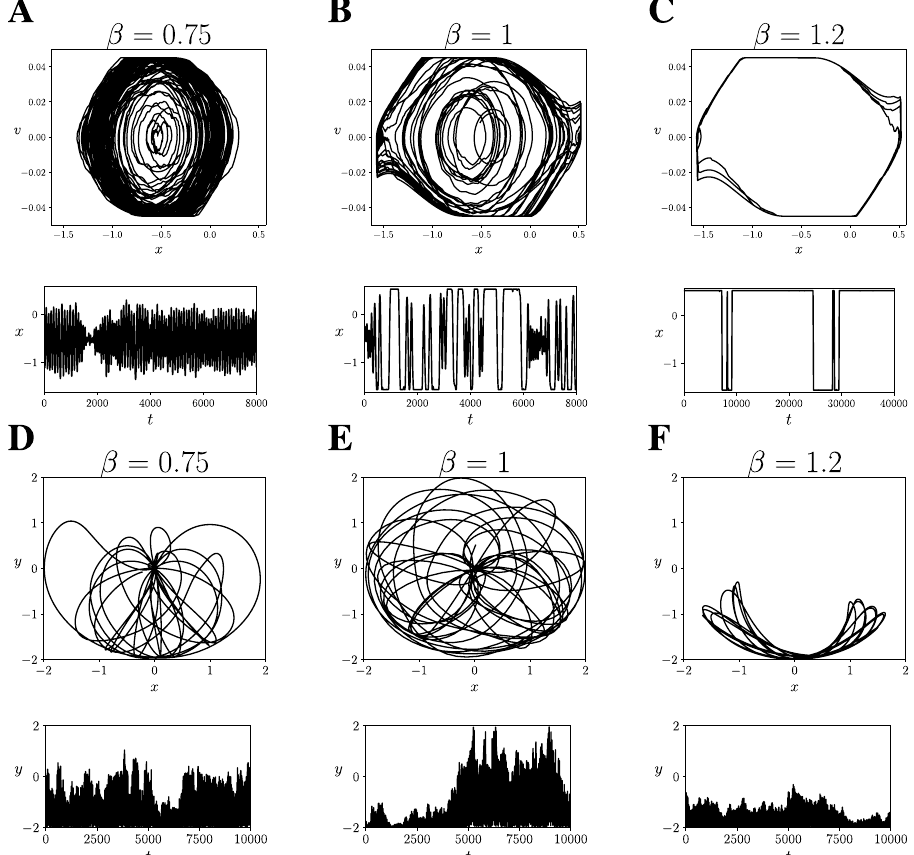
Figure 7. Transition in the behavioural regime of the agents with N h = 64. We show the behaviour of two individual agents with different values of β for the Mountain Car ( A – C ) and Acrobot ( D – F ) embodiments. We observe that β = 1 is a transition point between two modes of behaviour in both